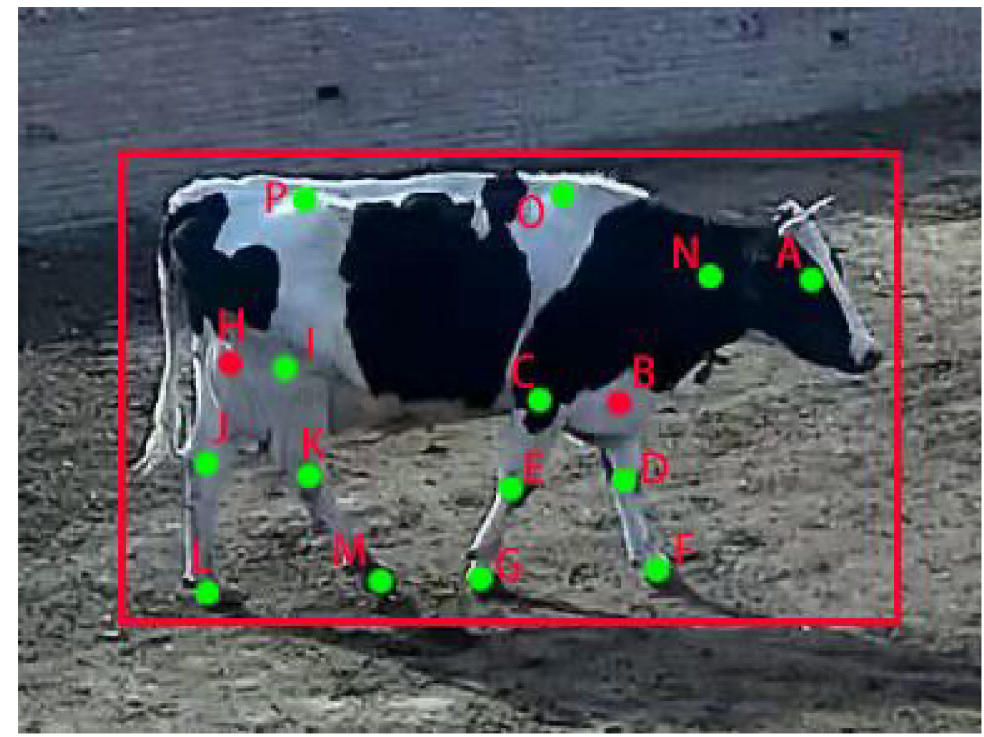
Fig 1. Keypoint label template of the cow